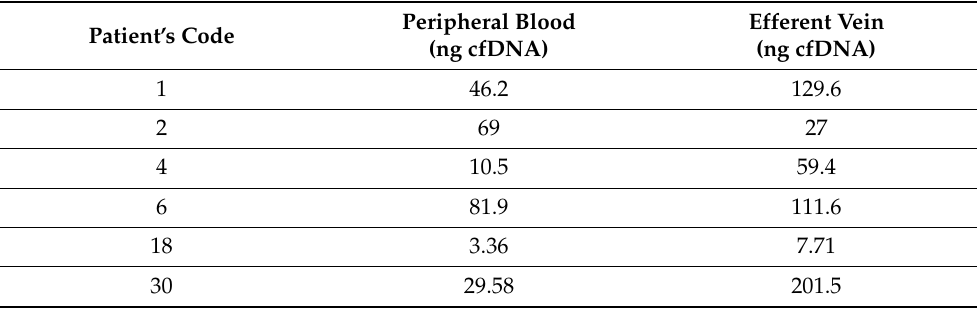
Table 2. cfDNA levels from plasma of both peripheral and efferent vein withdrawals. cfDNA concentrations are reported in the table for each patient. cfDNA total levels were higher in the efferent vein blood withdrawals than in peripheral blood.